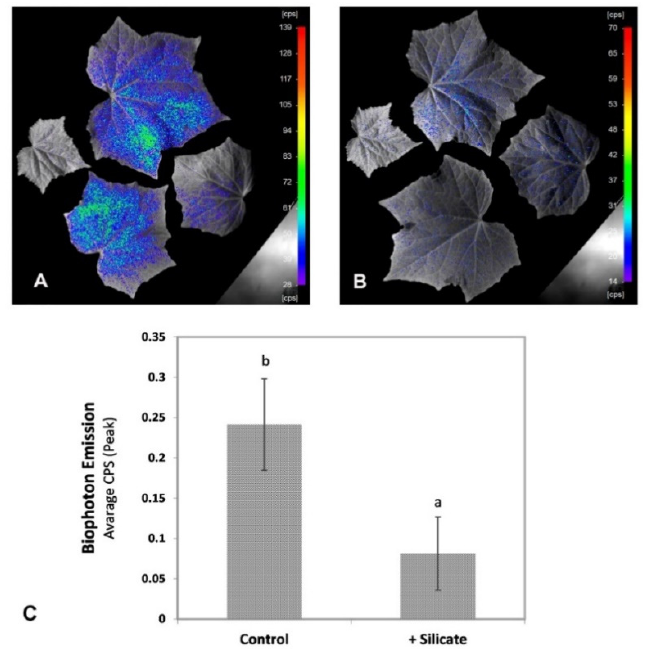
Figure 2. False colored images based on bioluminescence of typical ( A ): control and ( B ): silicate-treated plants. ( C ): Results of bio-photon emission (average count per second) in control and silicate-treated cucumber leaves. Bio-photon emission decreased significantly in response to Si treatment. Values are means ± SD and different letters above the bars indicate significant difference between the treatments (Tukey post hoc: p < 0.05); n ≥